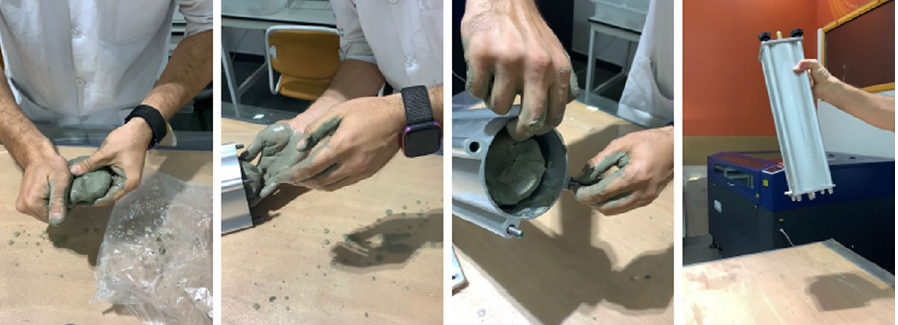
Fig. 2 Preparation and loaded clay into a